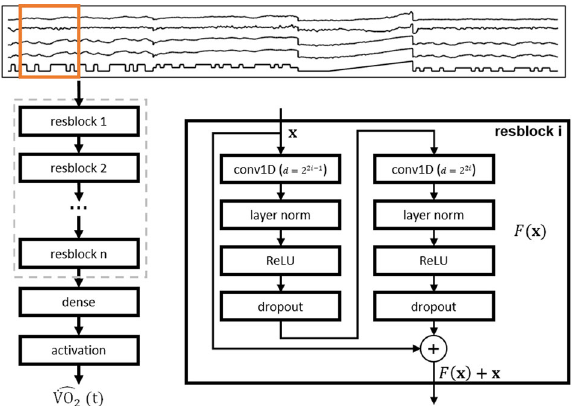
Fig. 1 Convolutional neural network architecture for temporal prediction of _ VO 2 . Temporal features (heart rate, heart rate reserve, breathing frequency, minute ventilation, and work rate) are processed through a series of residual blocks with causal convolu- tions and dilations for feature extraction, followed by a fully connected layer and linear activation to predict _ VO 2 at time t .